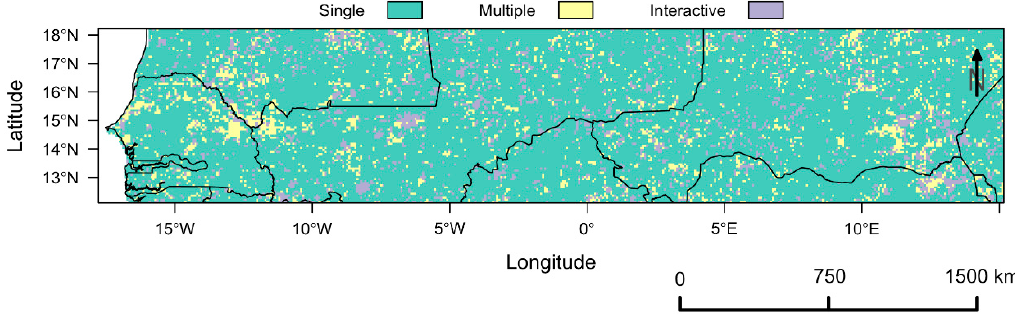
Figure D2. Maps of the West African (WA) study region of the mode of the shifting linear regression model (SLR) with the lowest AIC. “Single” = model with only rainfall of concurrent year as explanatory variable, “Multiple” = model with rainfall of concurrent year and previous year as additive variables and “Interactive” = model with an added interaction term of the “Multiple” model.